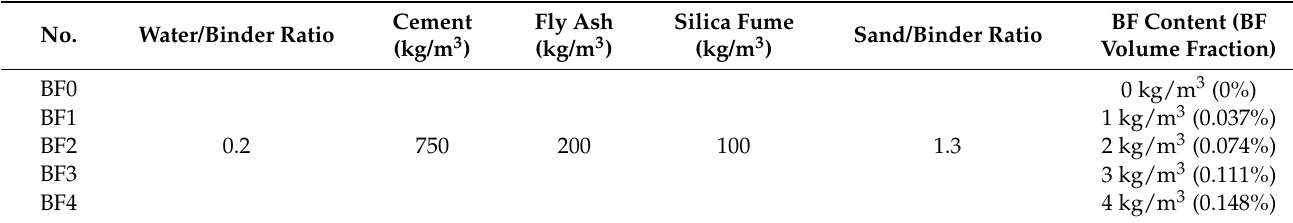
Table 2. Mix proportions of BFRPC.